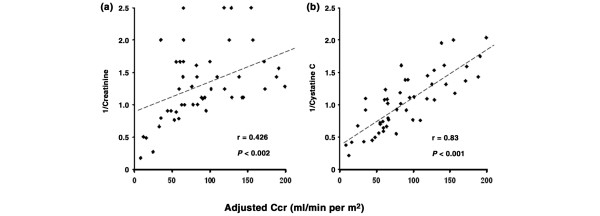
The (a) inverse of serum creatinine (1/creatinine) and the (b) inverse of cystatin C (1/cystatin c) were plotted against creatinine clearance (CCr) for each of patient (P = 0.002 versus P < 0.001).